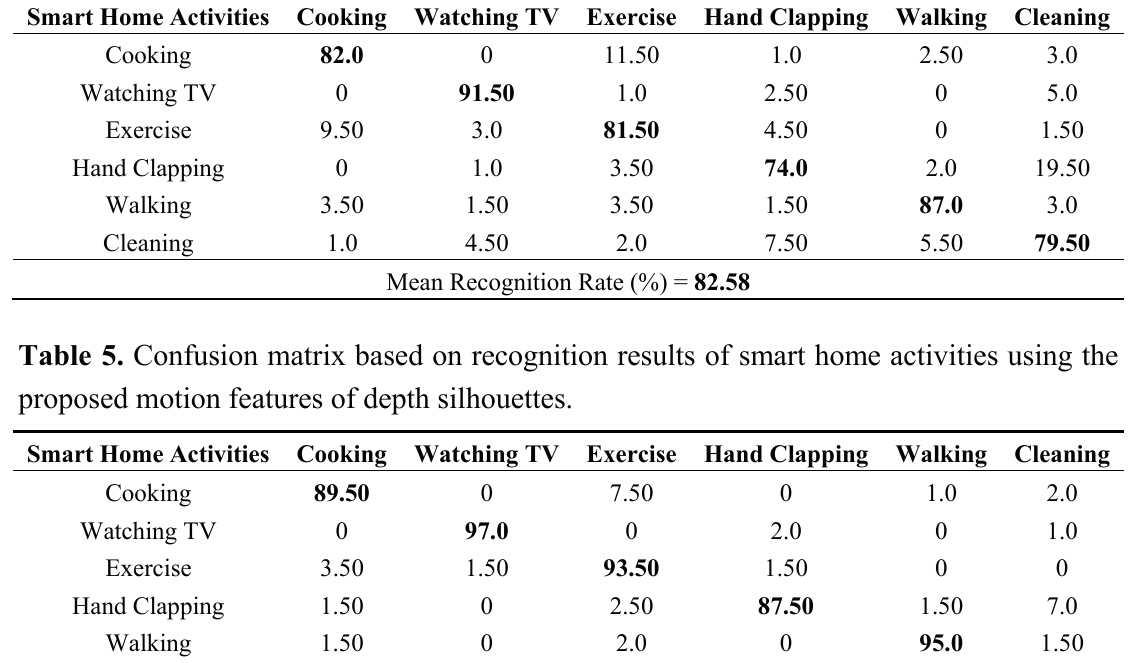
Table 4. Confusion matrix based on recognition results of smart home activities using IC features of depth silhouettes.